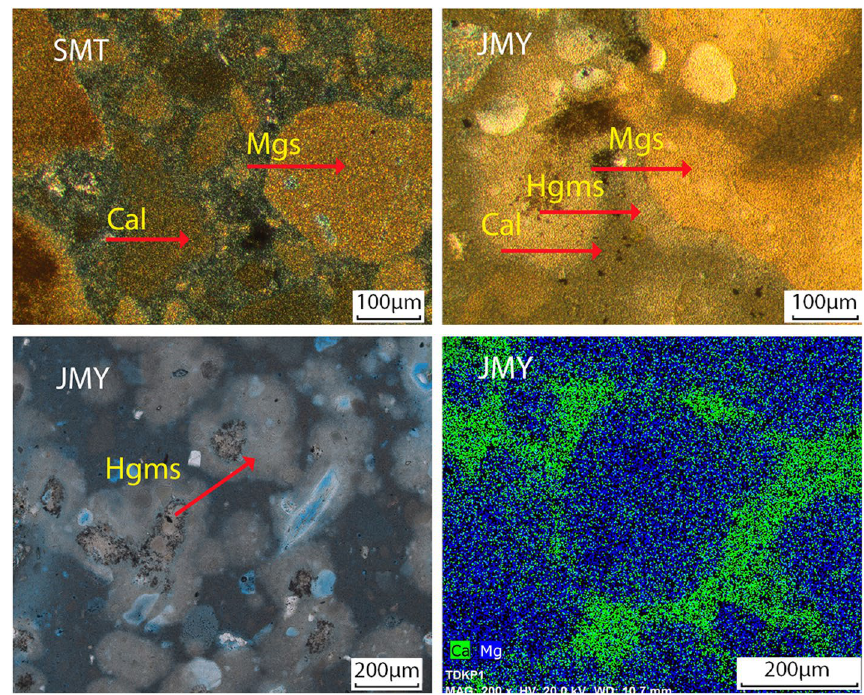
Fig. 19 Representative thin sections of the dolomitic lime mortars SMT Simatai and JMY Jiangmaoyu (top right and bottom) from Beijing. SMT-top left: bedding mortar with lumps of lime and the indication of dense magnesite (Mgs) and calcite (Cal) in crosspolarised light (xpl). JMY-top right: thin section image of dolomitic lime mortar with the intermediate hydromagnesite (Hgms) of the transformation process to Mgs, Cal or intergranular voids (ppl). JMY- bottom-left: Thin section image of dolomitic lime mortar showing spherulitic carbonate structures and intermediate Hgms in a transition zone (ppl). JMY-right: EDAX image of the Ca- and Mg-enriched regions visible in the thin section. (Source: Tanja Dettmering and Bernhard